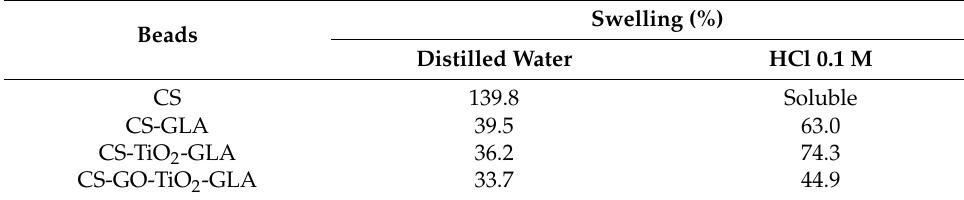
Table 7. Swelling percentages of the nanocomposite